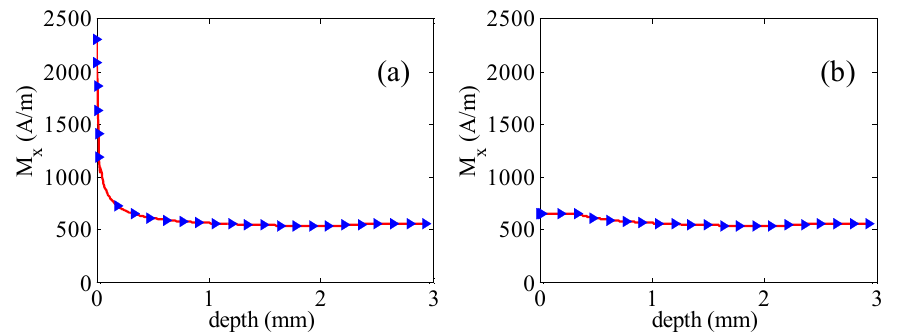
Figure 4. Magnetization distribution. ( a ) M x in bottom region remains unchanged and ( b ) M x remains unchanged.